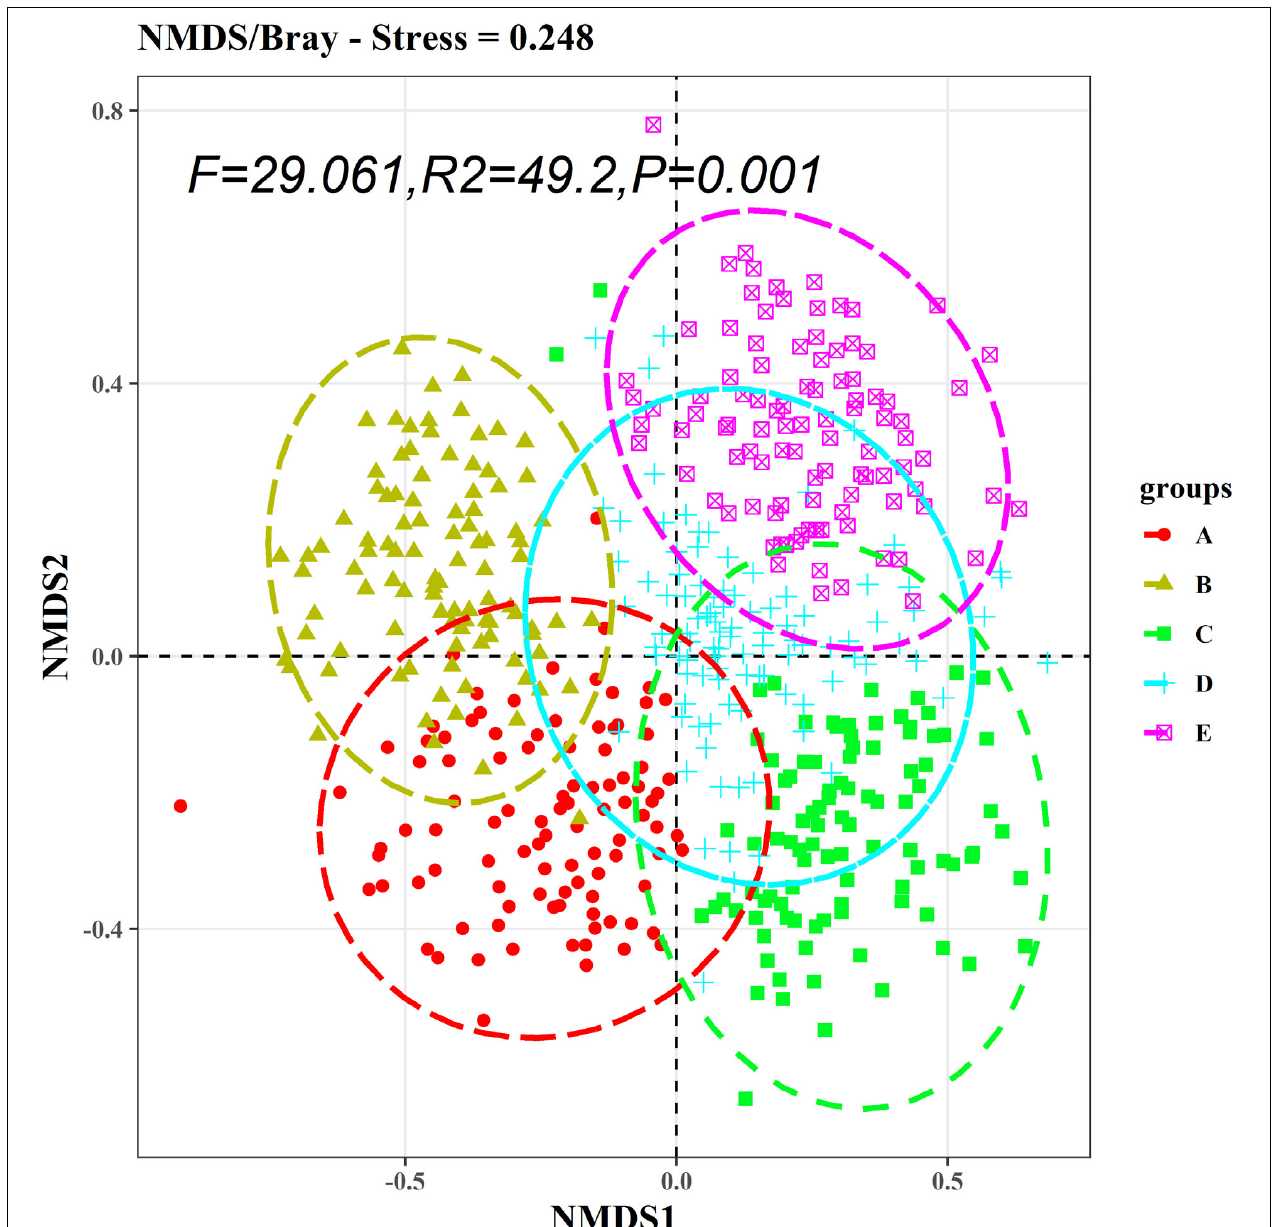
FIGURE 4 | NMDS analysis of species composition among five communities. PERMANOVA was used to evaluate intercommunity significance. A, B, C, D, and E were the Quercus variabilis community, Quercus glandulifera var. brevipetiolata community, Mixed broadleaf-conifer community, Quercus aliena var. acutiserrata community, and Miscellaneous wood community,